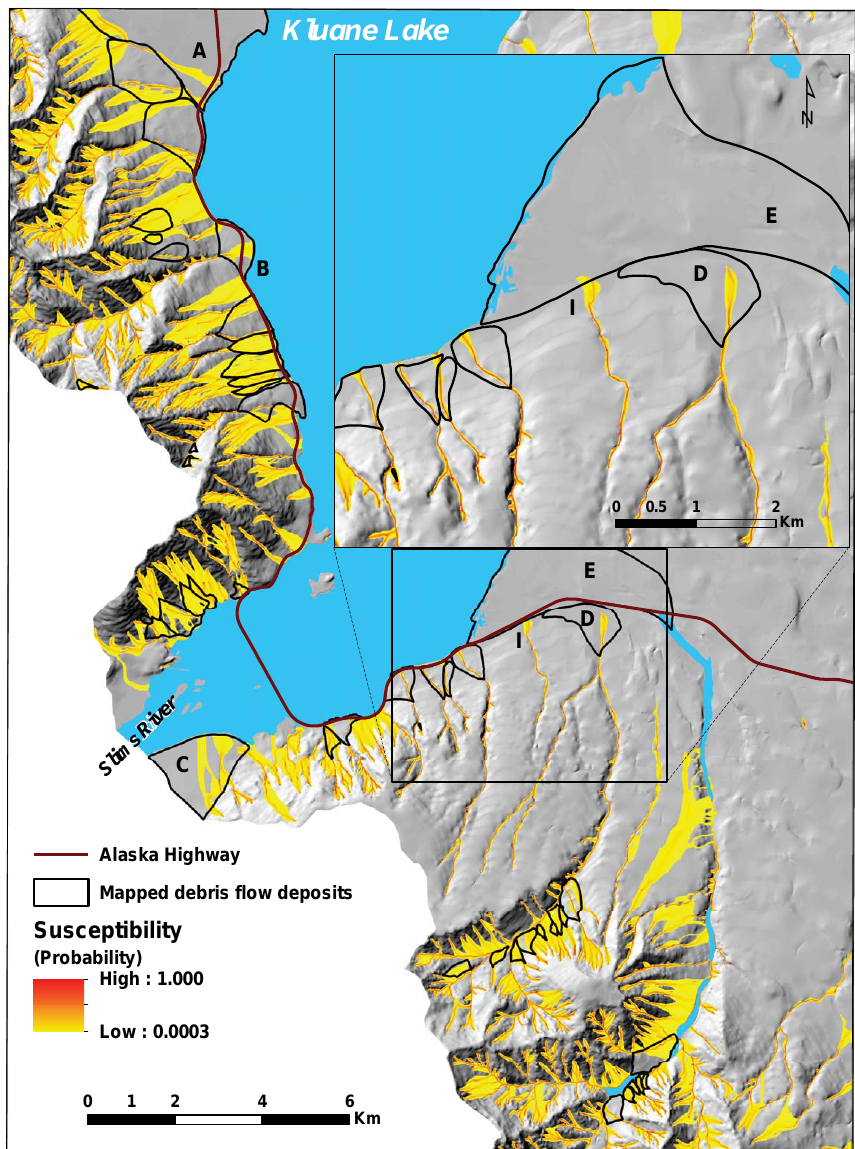
Figure 6. Debris flow susceptibility map derived from propagation of source areas using ω = 150 and µ = 0.02. Note no propagation reaches debris flow deposit